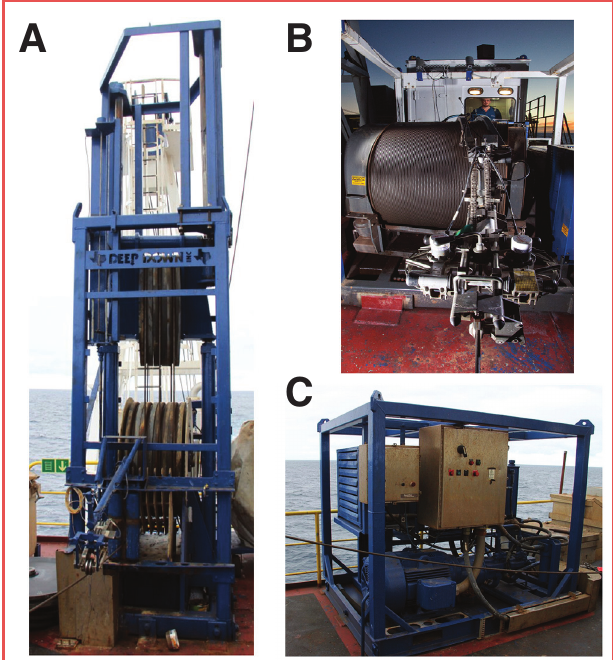
Figure 1. Photographs showing [A] the Proteus™ compensator unit, [B] wireline winch, and [C] hydraulic power unit (HPU). These units are located on a starboard side platform above the rig floor onboard the JOIDES Resolution . The Proteus unit is a hydraulic ram-type compensator with a set of sheaves mounted in an overhead flying head that moves vertically in opposite direction to the ship’s motion. The sheave assembly contains six active cable legs that reduce the compensator stroke-to-heave movement by 6:1. A high-performance Vickers/Eaton servo valve controls a pump supplying the hydraulic rams and operates on signals originating from the position control system. To control the servo valve, the AHC system uses ship motion information acquired by the motion reference unit (MRU) and its accelerometer package that is located in the ship’s center of